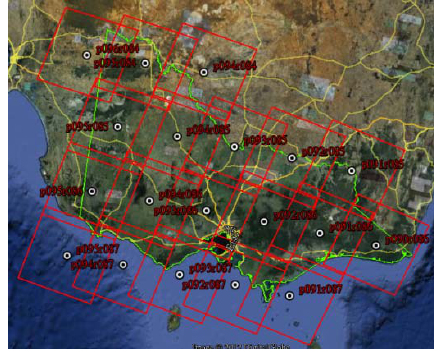
Figure 2. Study images information